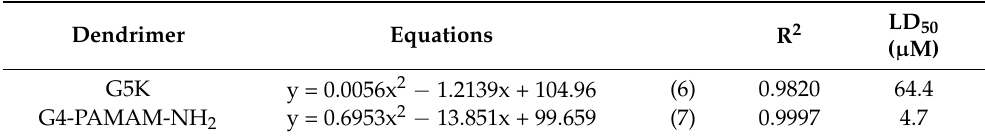
Table 2. Equations (6) and (7) and the LD 50 values of G5K and of paclitaxel for HeLa cells (24 h).